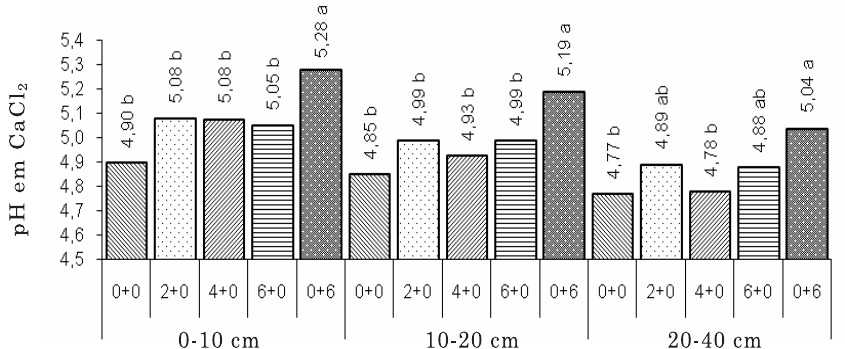
Figura 1. pH em CaCl no solo para a interação Tratamentos x Profundidades (Médias acompanhadas de 2 mesma letra, dentro de profundidade, não diferem estatisticamente entre si pelo teste de